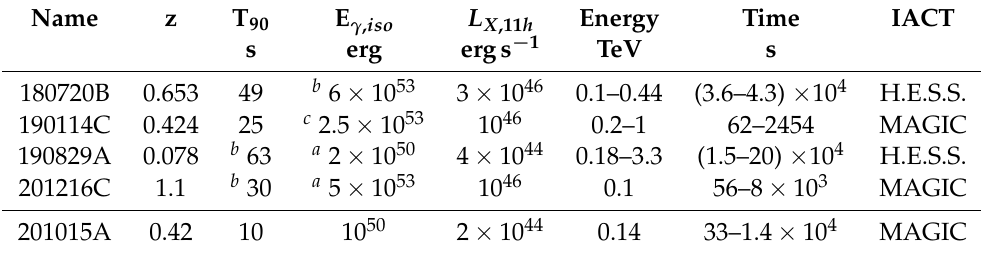
Table 1. List of the GRBs detected by IACTs. The columns refer to the GRB name, redshift, duration ( T 90 ) and isotropic-equivalent emitted energy E γ ,iso of the prompt emission, XRT luminosity ( L X,11h ) integrated between 2–10keV (rest frame) at 11h after T 0 , the energy range of detected TeV photons, the initial and final time of VHE detection, and the name of the IACT that detected VHE radiation. For all GRBs the time of the VHE detection refers to BAT trigger, except for 190829A, for which the GBM trigger was adopted. For GRBs listed in the first four rows, the significance of the VHE detection was > 5 σ , while for the last GRB in the table, the significance was 3.5 σ . a